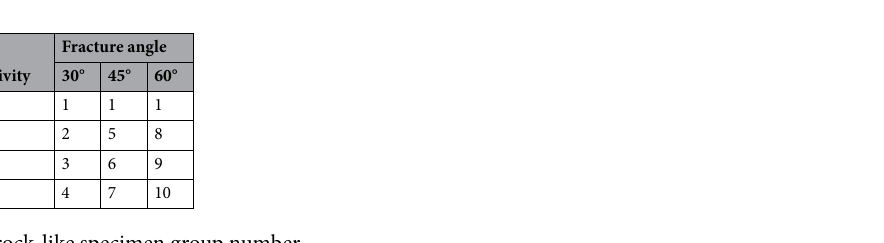
Table 4. Soft rock-like specimen group